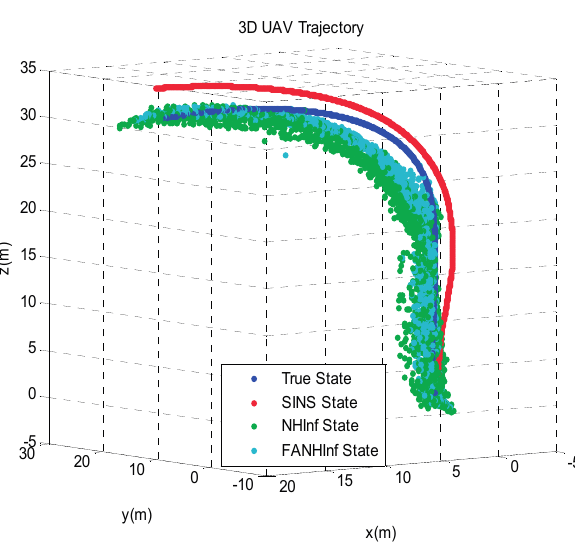
Figure 11. Error covariance in x